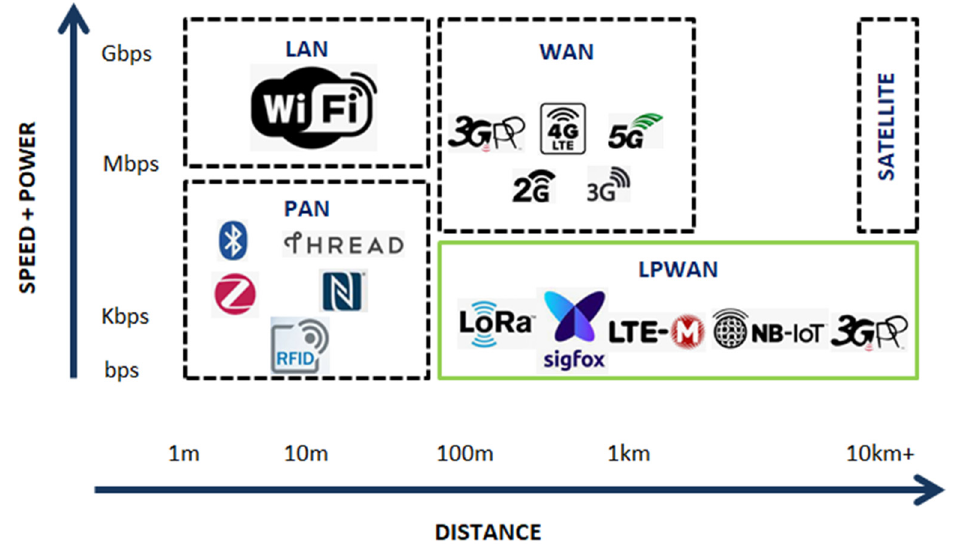
Figure 2. LPWAN compared with the popular LAB, PAN and WLAN existing technologies in terms of networks’ distance, data speed and power consumption properties.